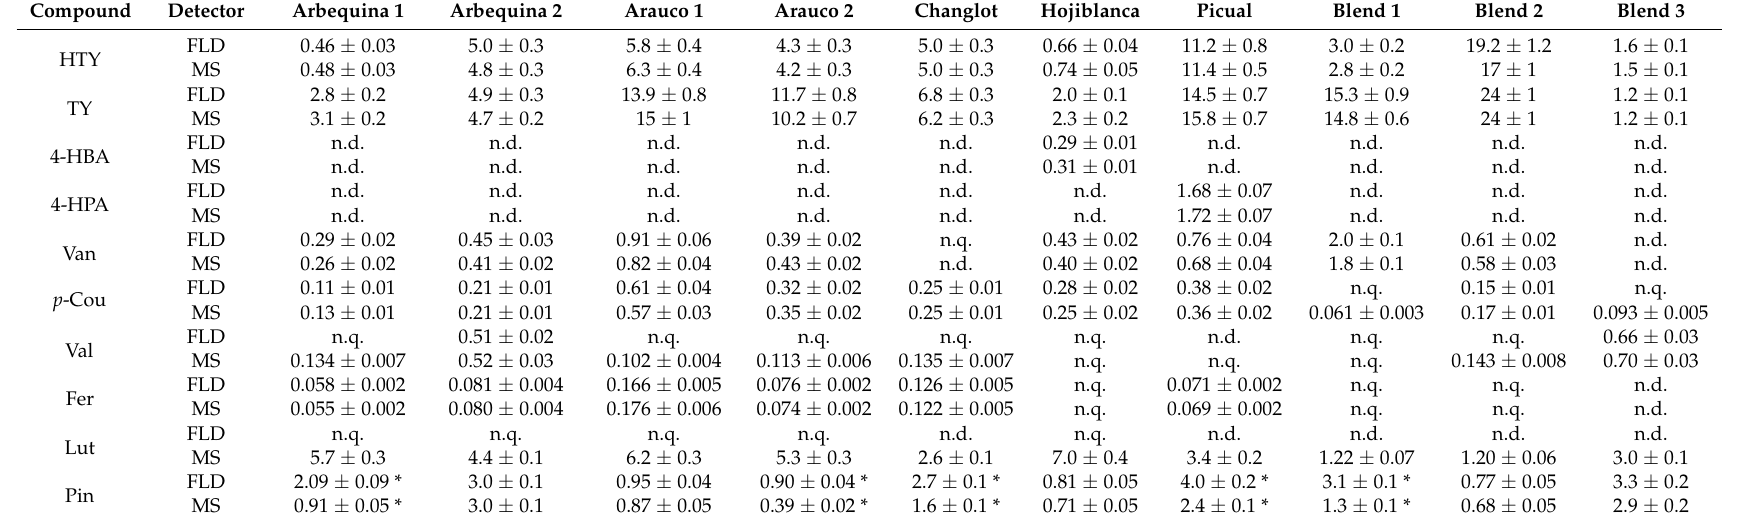
Table 3. Content of phenolic compounds with available commercial pure standard (expressed in µ g · g − 1 ) determined by FL and MS detectors coupled to LC.